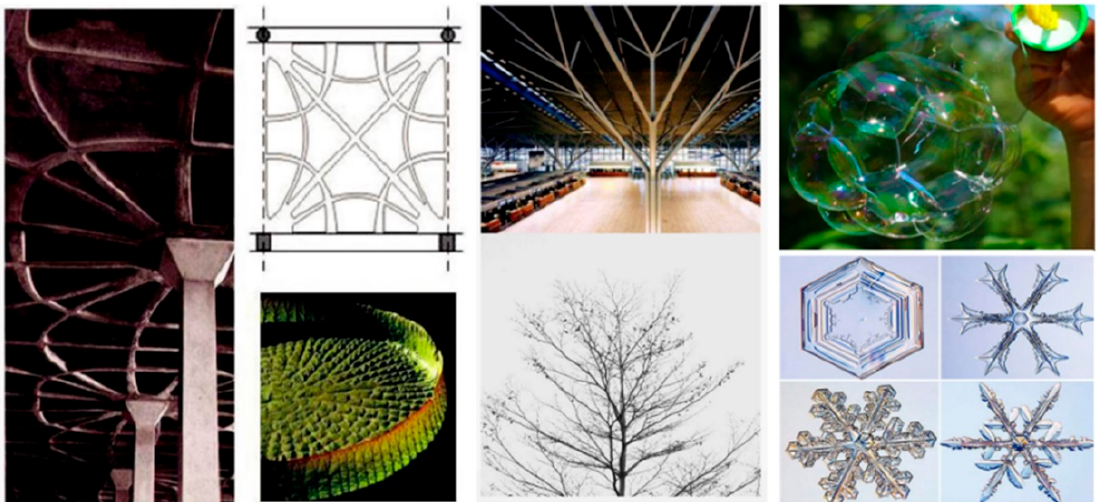
Figure 30. Mechanical structures in nature.